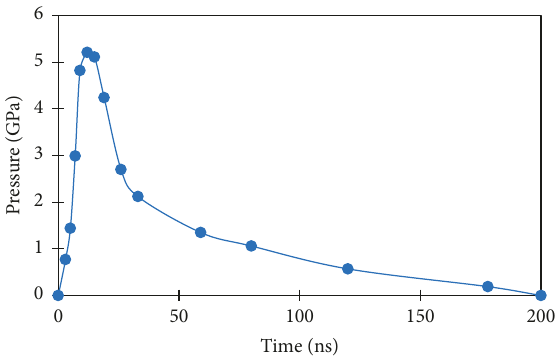
Figure 6: Plasma pressure profile. Table 1: Johnson-Cook parameters for DSS